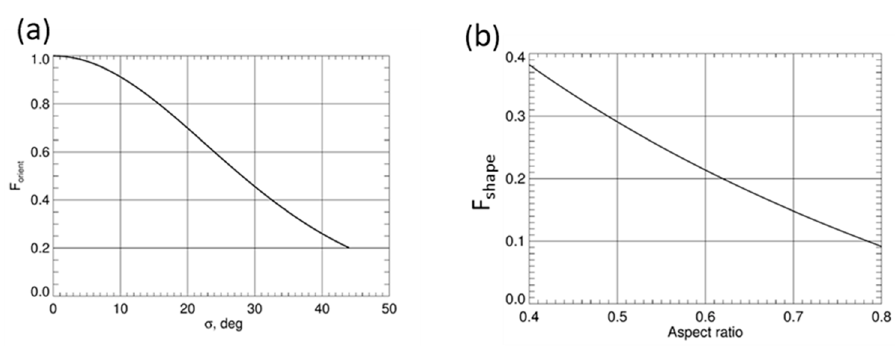
Figure 14. ( a ) Orientation factor F o as a function of the width the of canting angle distribution σ ; ( b ) shape factor F s as a function of the particle aspect ratio.